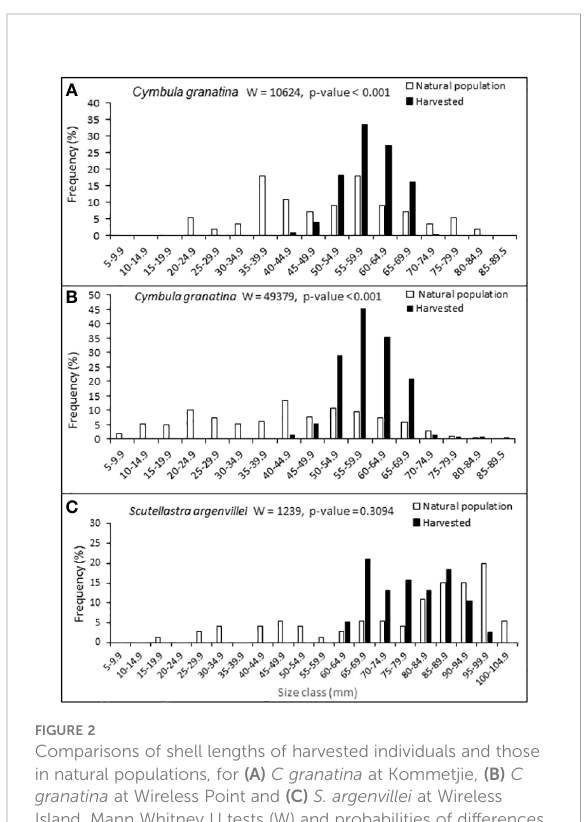
FIGURE 2 Comparisons of shell lengths of harvested individuals and those in natural populations, for (A) C granatina at Kommetjie, (B) C granatina at Wireless Point and (C) S. argenvillei at Wireless Island. Mann Whitney U tests (W) and probabilities of differences between sizes of harvested and natural samples are shown. Sample sizes for respectively harvested and natural samples were n=280 and n=56 for Kommetjie, n=298 and n=209 for Wireless Point, n=38 and n=72 for Wireless